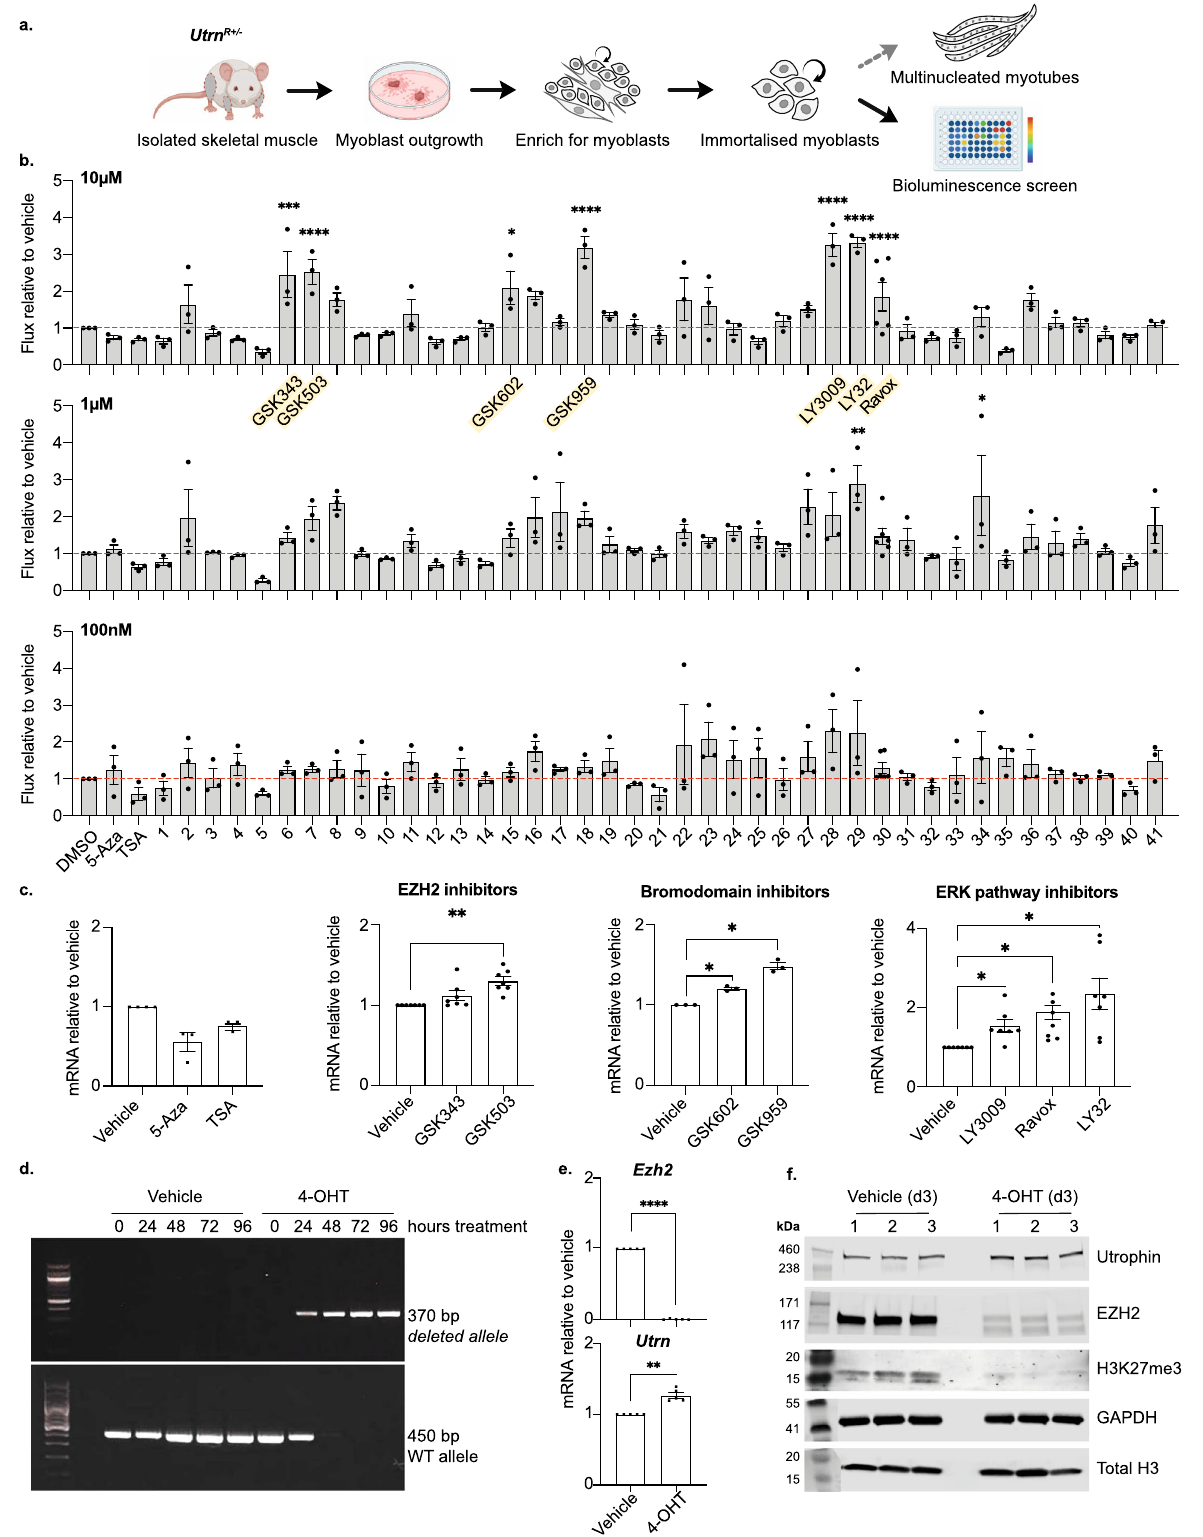
increasing approximately 3-fold over the differentiation time course. Likewise, a dose dependent increase in both Utrn and Dmd expression was observed after LY32 treatment. Taken together, our data support the hypothesis that ERK1/2 inhibitors induce the precocious expression of muscle-associated genes that are normally expressed as myoblasts differentiate into